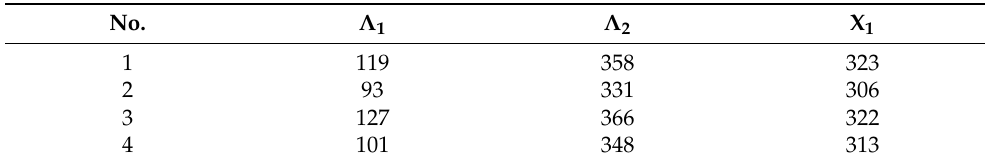
Table 1. Parameter sets for acquiring coordinates on the pond surface from the Ao-ike Pond images listed in Figure 13. “No.” corresponds to Figure 13.